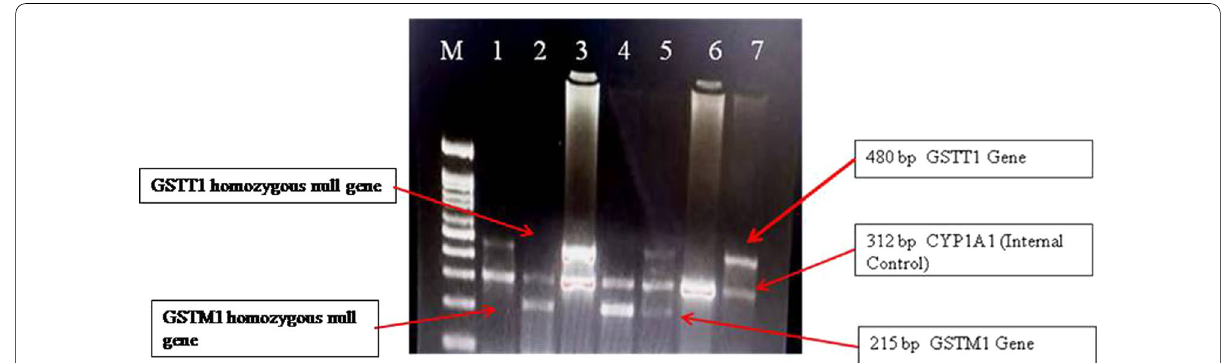
Fig. 1 2% agarose gel is showing M lane is 100 pb marker, in lane 1, 3 and 7 are showing GSTT1 non-null and GSTM1 homozygous null genotyping. Lane 2 and 4 are showing GSTM1 non-null and GSTT1 homozygous null genotyping. Lane 5 is showing both GSTM1 and GSTT1 non-null genotyping and Lane 6 is showing both GSTM1 non-null and GSTT1 homozygous null